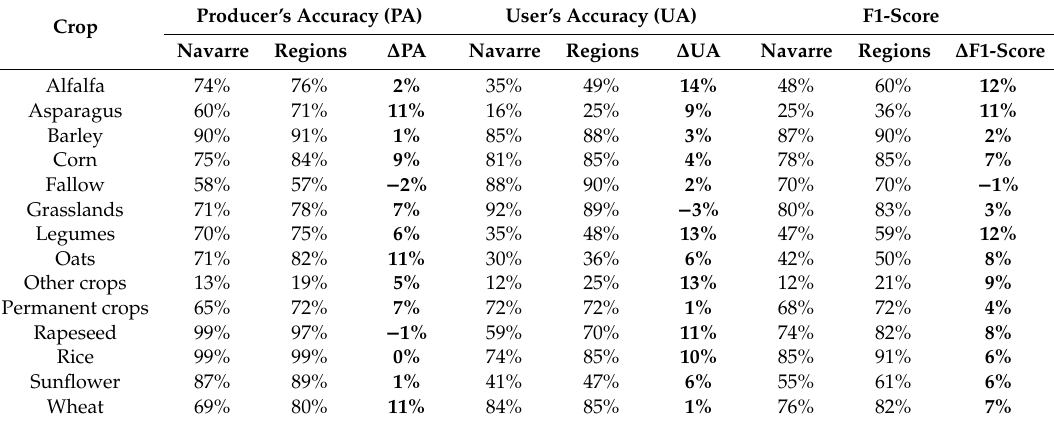
Table 6. Increment ( ∆ ) in crop accuracy (PA, UA and F1-sore) when the stratified regional results are compared to Navarre’s results for Ens scheme (using R 2 as the best fit metric).